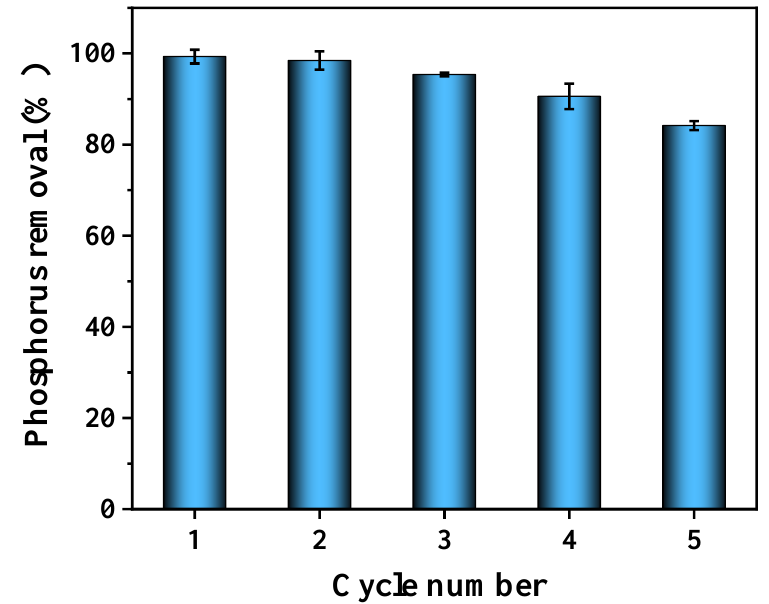
Figure 7. The recycling of 2MgO/BC-450-0.5 for phosphorus adsorption.